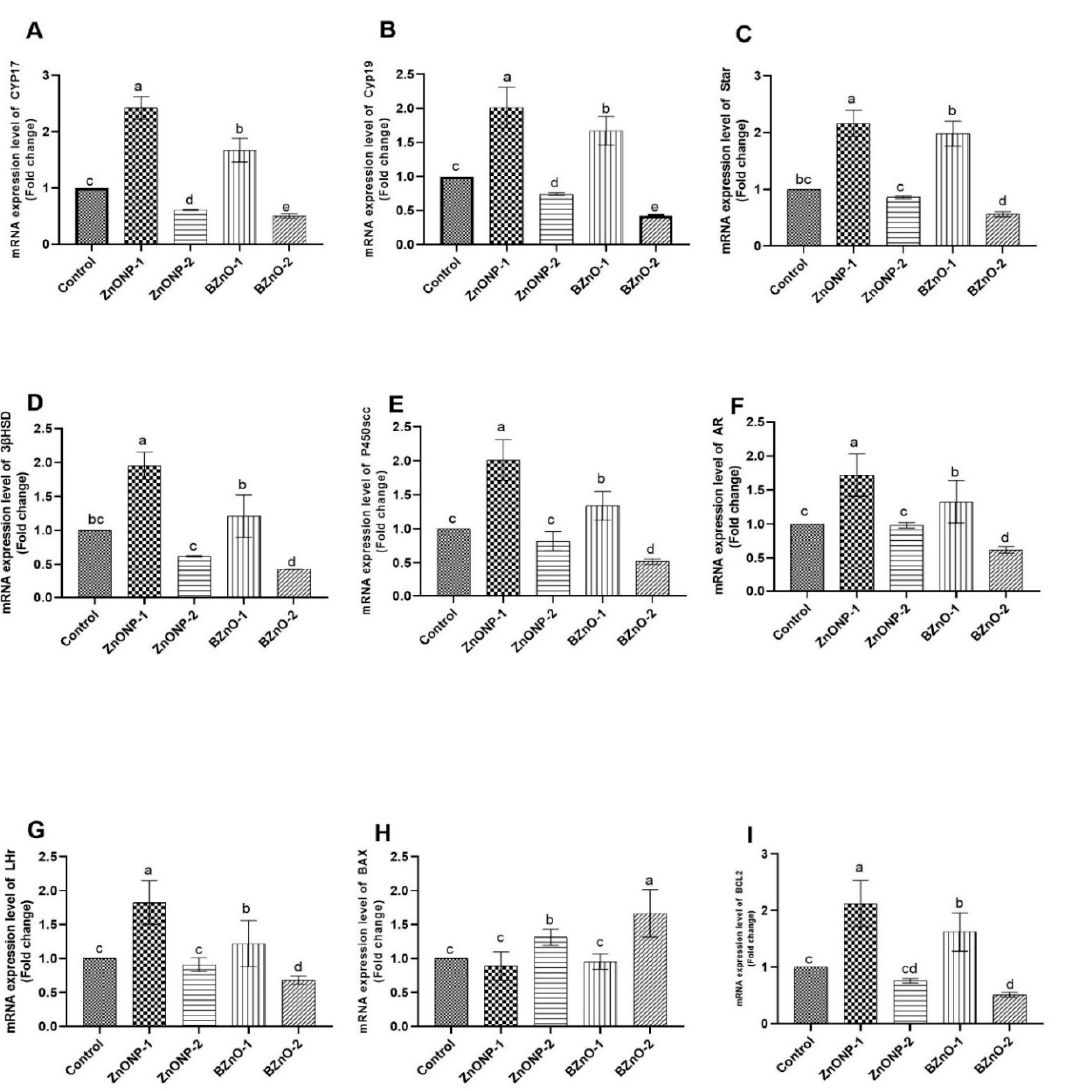
Figure 7. Effect of the ZnONPs and BZnO at different doses on testicular gene expression: ( A ) CYP17A1; ( B ) CYP19; ( C ) STAR; ( D ) 3 β -HSD; ( E ) P450SCC; ( F ) AR; ( G ) LHR; ( H ) Bax, Bcl-2-associated X protein Bax; ( I ) Bcl-2, B-cell lymphoma 2 (Bcl2). All the values are expressed as the mean ± SEM. Different small letters indicate significance at p < 0.05.